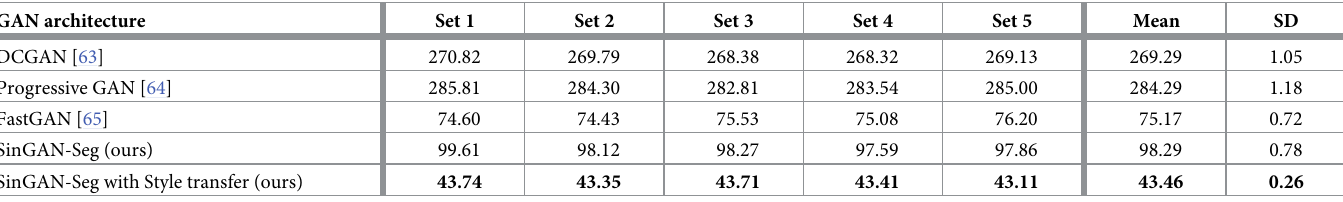
Table 4. FID value comparison between the real dataset of 1000 real images and the synthetic datasets of 1000 synthetic images generated from different GAN archi- tectures which are modified to generate four channels outputs. GAN architecture Set 1